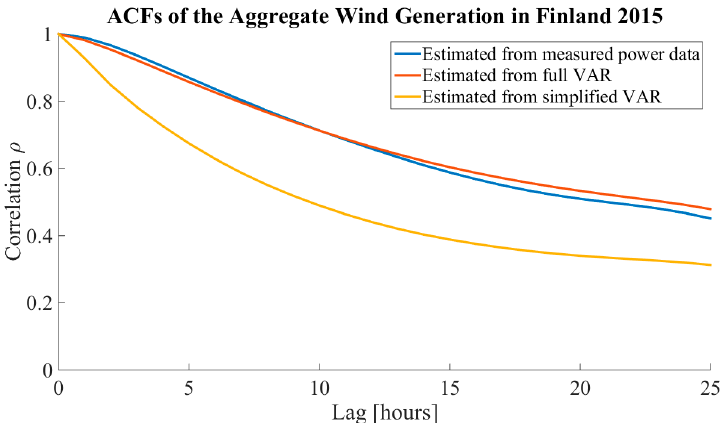
Figure 9. The ACFs estimated from the measured aggregated wind power generation in Finland in 2015 and from the aggregated simulated data from the two models. The presented simulation results are averages of the 100 MC runs.